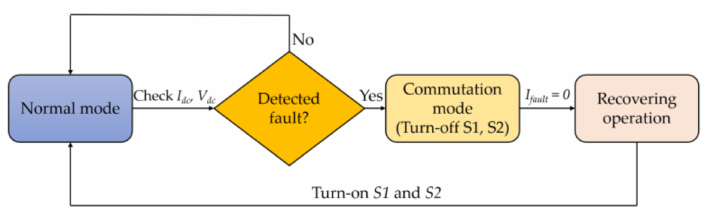
Figure 12. Proposed SSCB control block diagram.